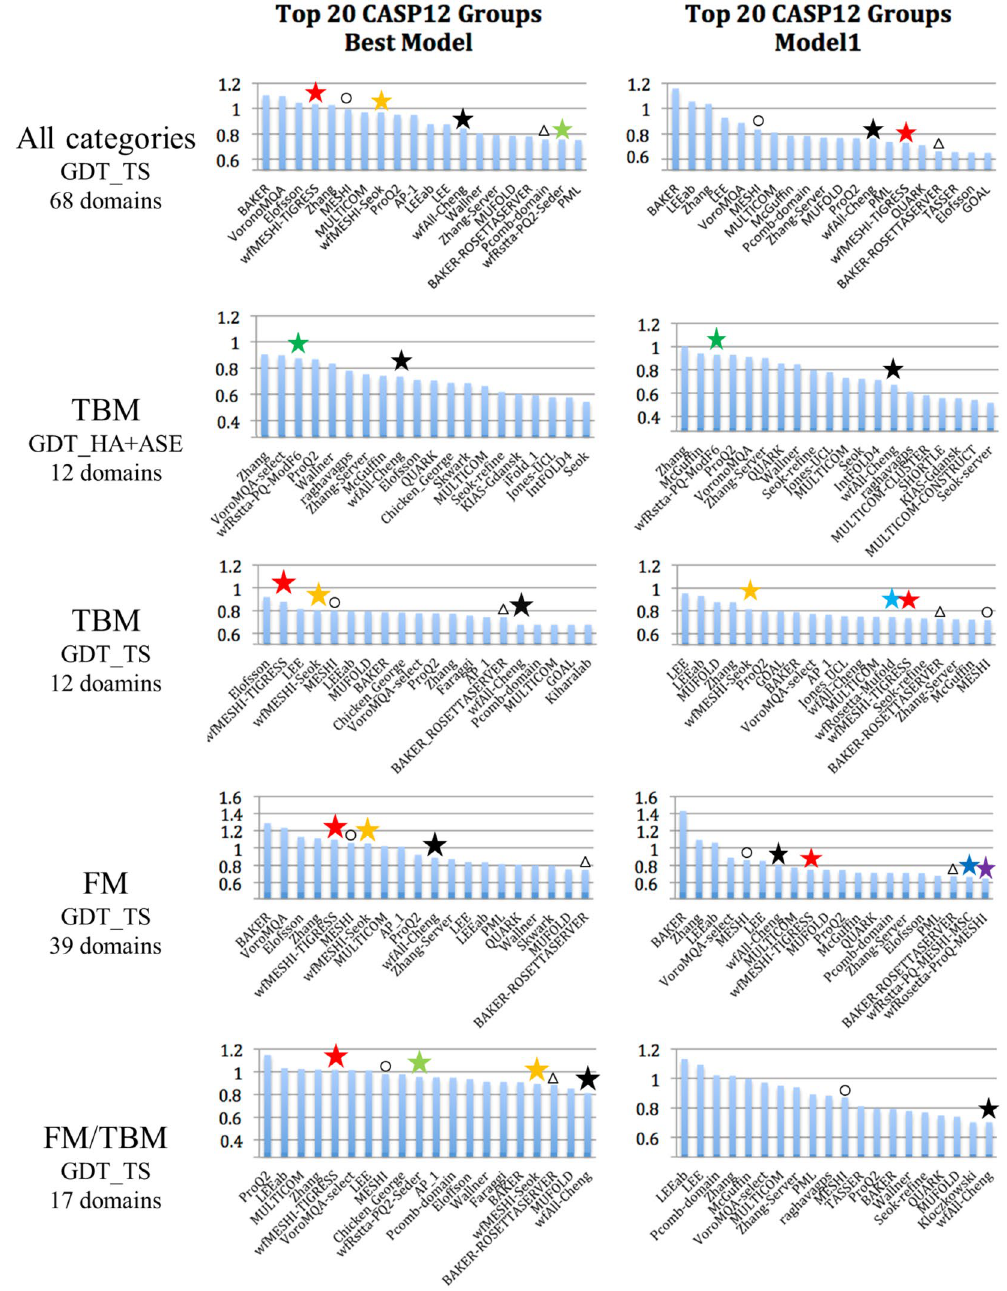
Figure 4. Average z-scores ( >− 2.0) of the 20 top CASP12 groups, WeFold pipelines are marked with asterisks (Black = wfAll-Cheng; Red = wfMESHI-TIGRESS; Orange = wfMESHI-Seok; Light green = wfRstta-PQ2- seder; Dark green = wfRstta-PQ-ModF6; Light blue = wfRosetta-MUFOLD; Dark blue = wfRstta-PQ-MESHI- MSC; Purple = wfRosetta-PQ-MESHI). The results of MESHI and BAKER-ROSETTASERVER are marked by black circle and triangle respectively. Only those groups that submitted models for at least half of the targets are considered. Chart on the left shows top 20 groups/servers when considering the best model submitted by each group for each target. Chart on the right shows top 20 groups/servers when considering Model 1 only. CASP assessors used GDT_HA + ASE only for TBM targets hence the double depicting of that category. Source: http://